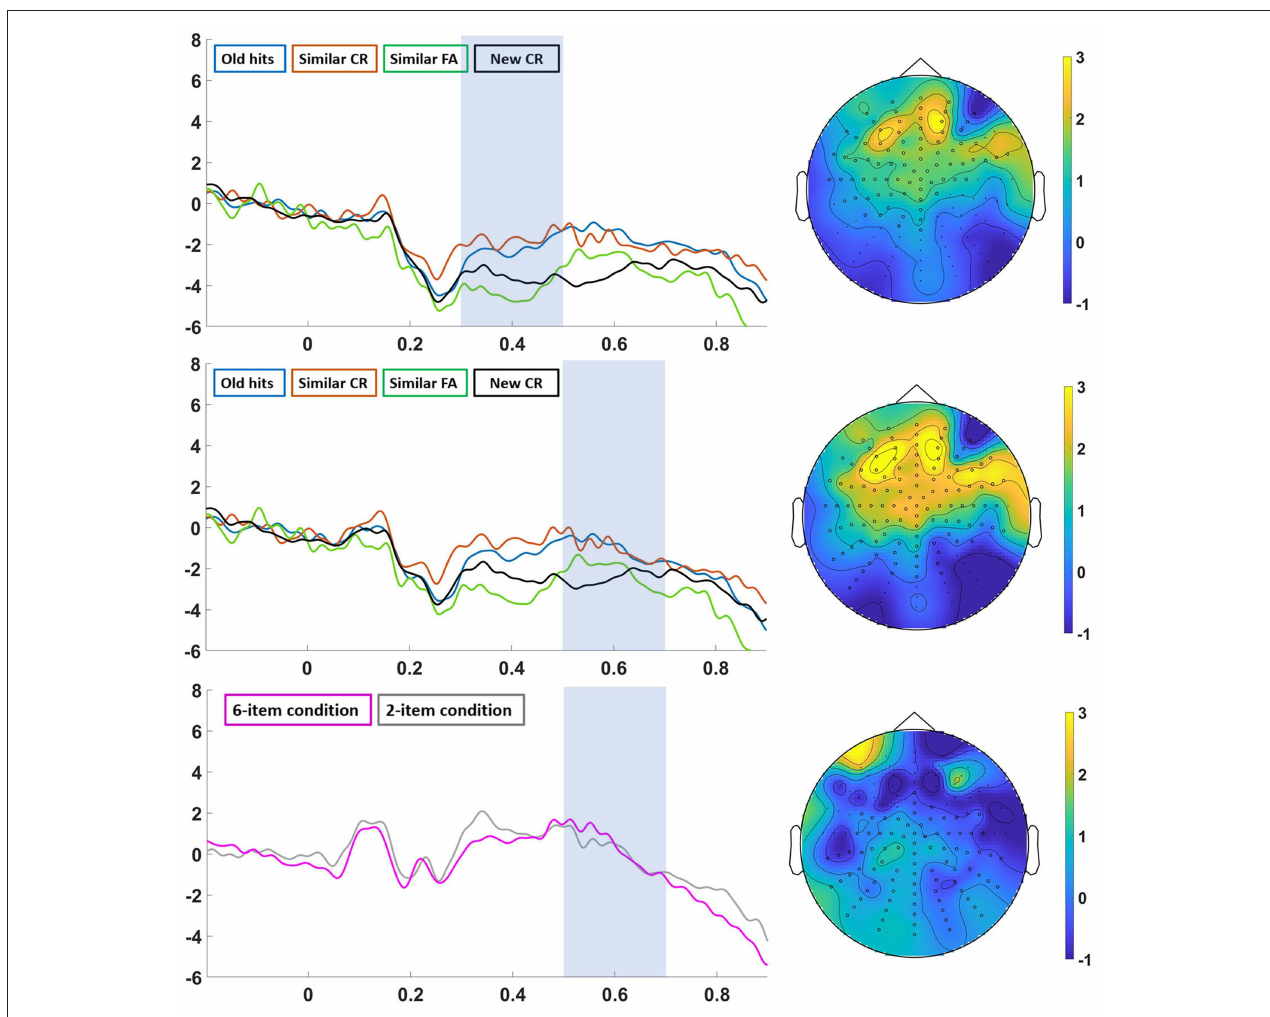
FIGURE 5 | “Analysis in the 24-h group”. Left: ERPs from “old hits” (blue line), “similar CR” (red line), “similar FA” (green line) and “new CR” (black line) in the 300–500ms (top) and 500–700ms (middle) time window, and ERPs from “6-item condition” (pink line) and “2-item condition” (gray line) in the 500–700ms time window (down). Right: topographic map of the grand-average of “old hits-new CR” in the 300–500ms time window (top), “old hits-new CR” (middle) in the 500–700ms time window (middle), and “6-item condition-2-item condition” in the 500–700ms time window